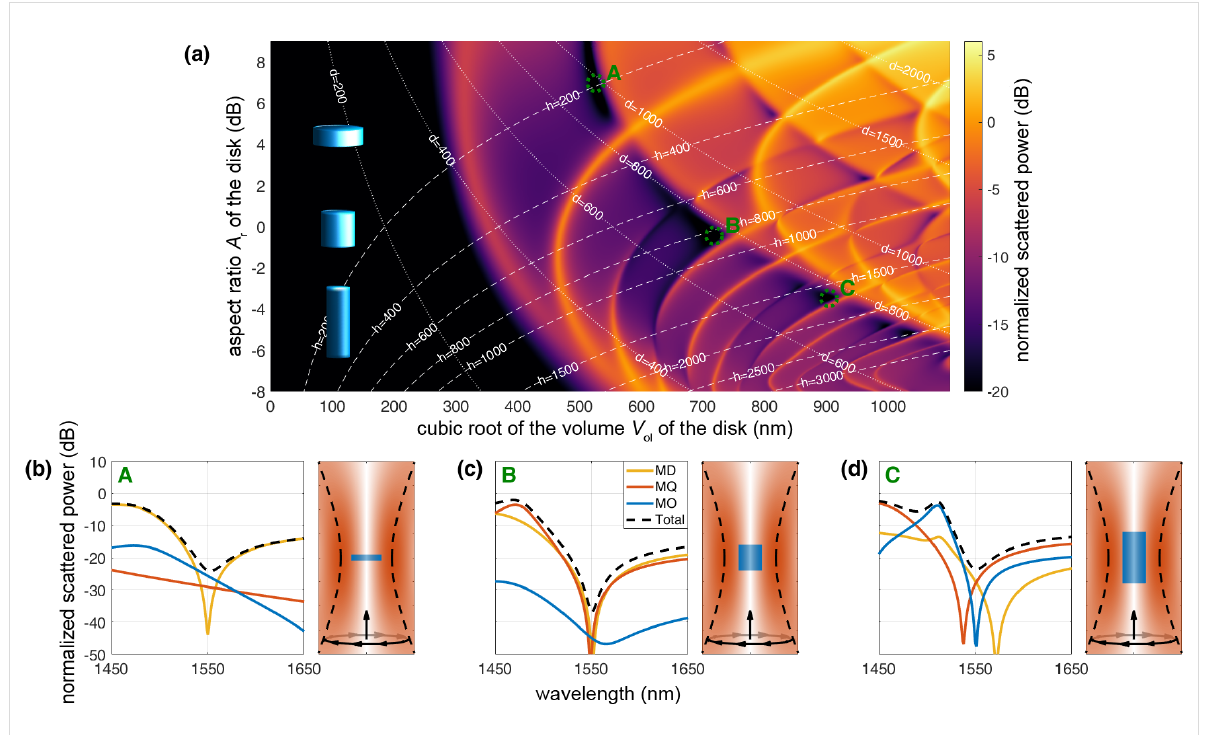
Figure 2: a) 2D plot of the normalized scattered power ( P sca / P inc ) in dB as a function of the cubic root of the volume V ol of the disks and the aspect ratio A r of the disks. Isoheight (dashed) and isowidth (dotted) contour lines in terms of the dimensions of the disks (in nm) are plotted as well. The silicon disks are located at the focal point of a rotationally symmetric, azimuthally polarized vector beam at λ 0 = 1550nm. Three cases of excited anapole states are highlighted with A, B and C, the multipolar decomposition of the scattering spectrum of which, is depicted in subfigures b-d respec- tively. On the right side of them, there are illustrations of the actual E-field intensity of the excitation over a window of 2x4 wavelengths at the focal region, with a disk of the corresponding dimensions placed at the focal